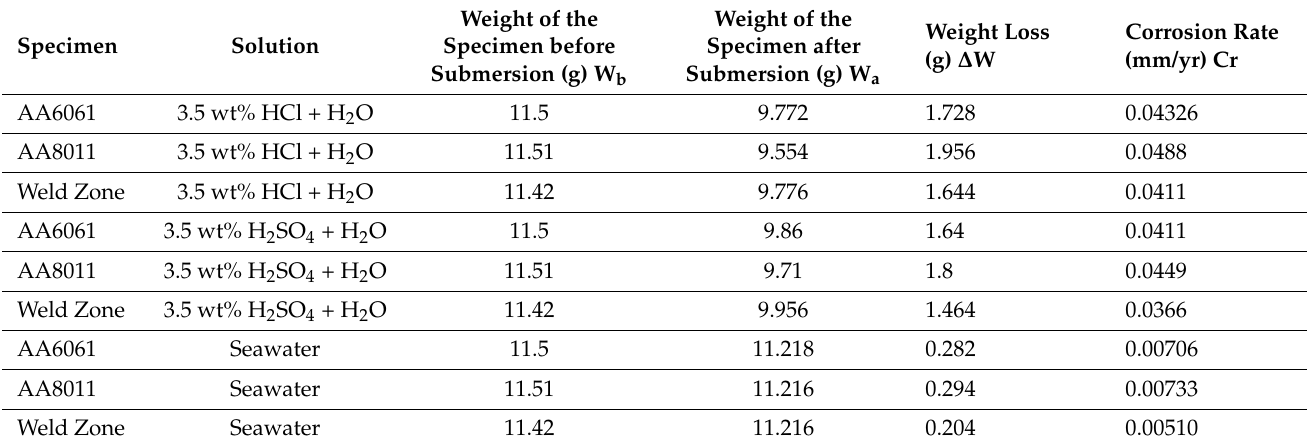
Table 6. Summary of the submersion test.